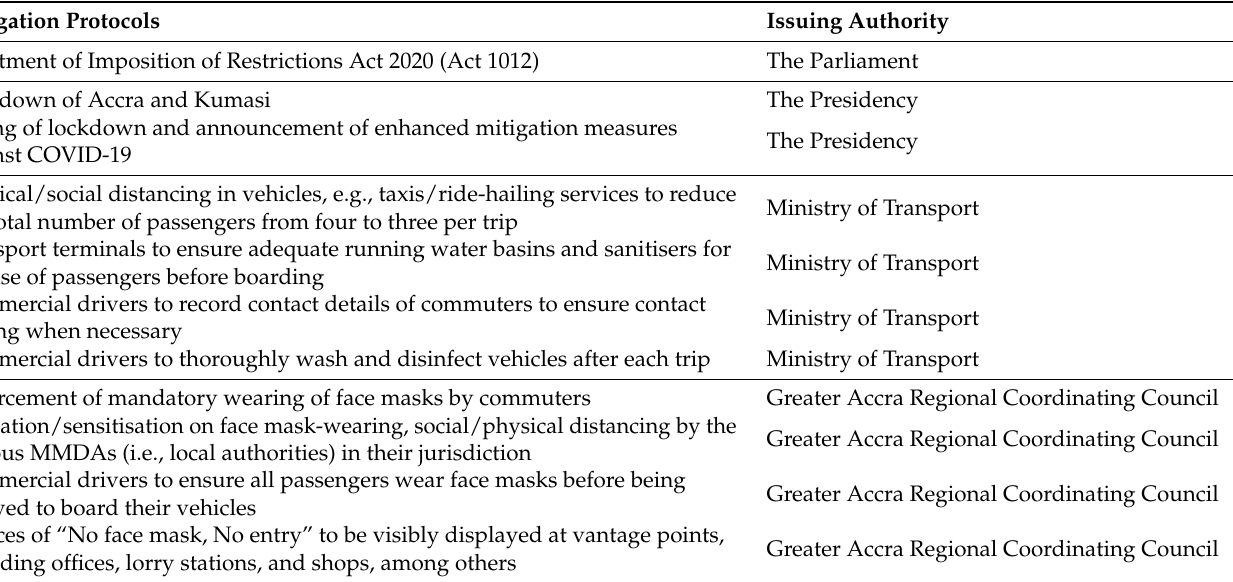
Table 1. COVID-19 mitigation protocols for public transport